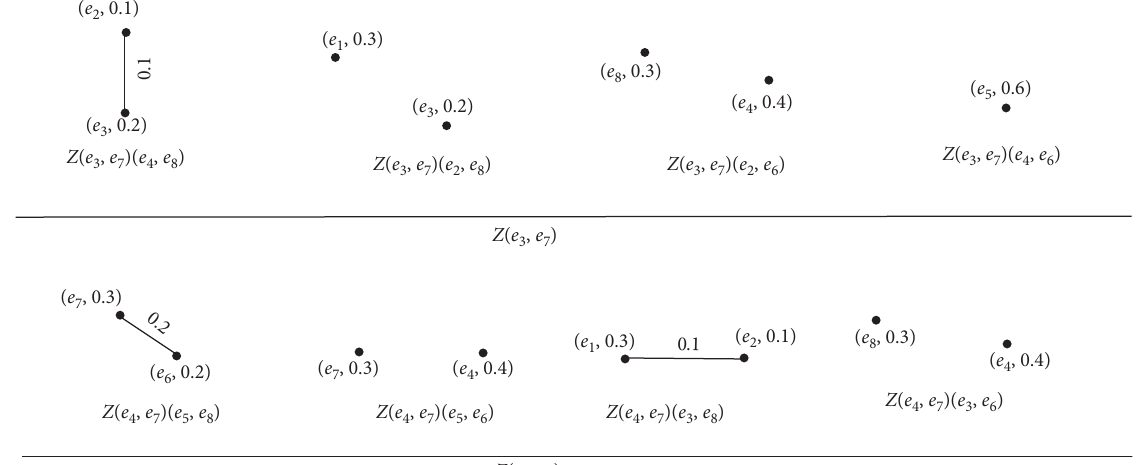
Figure 22: AND operation of G and G ′ is G ∧ G ′ � ( Z ( e